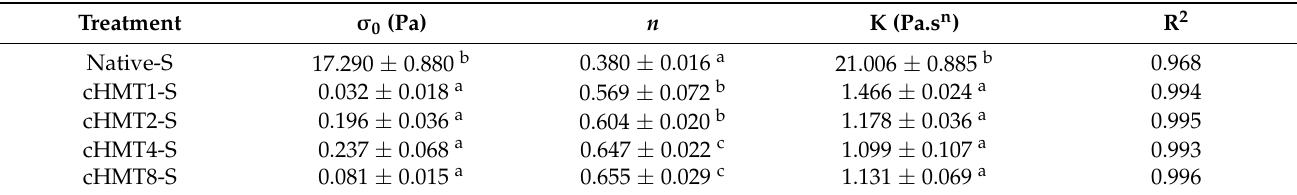
Table 3. Herschel–Bulkley model parameters of native and cHMT water caltrop starch 1,2 . Treatment